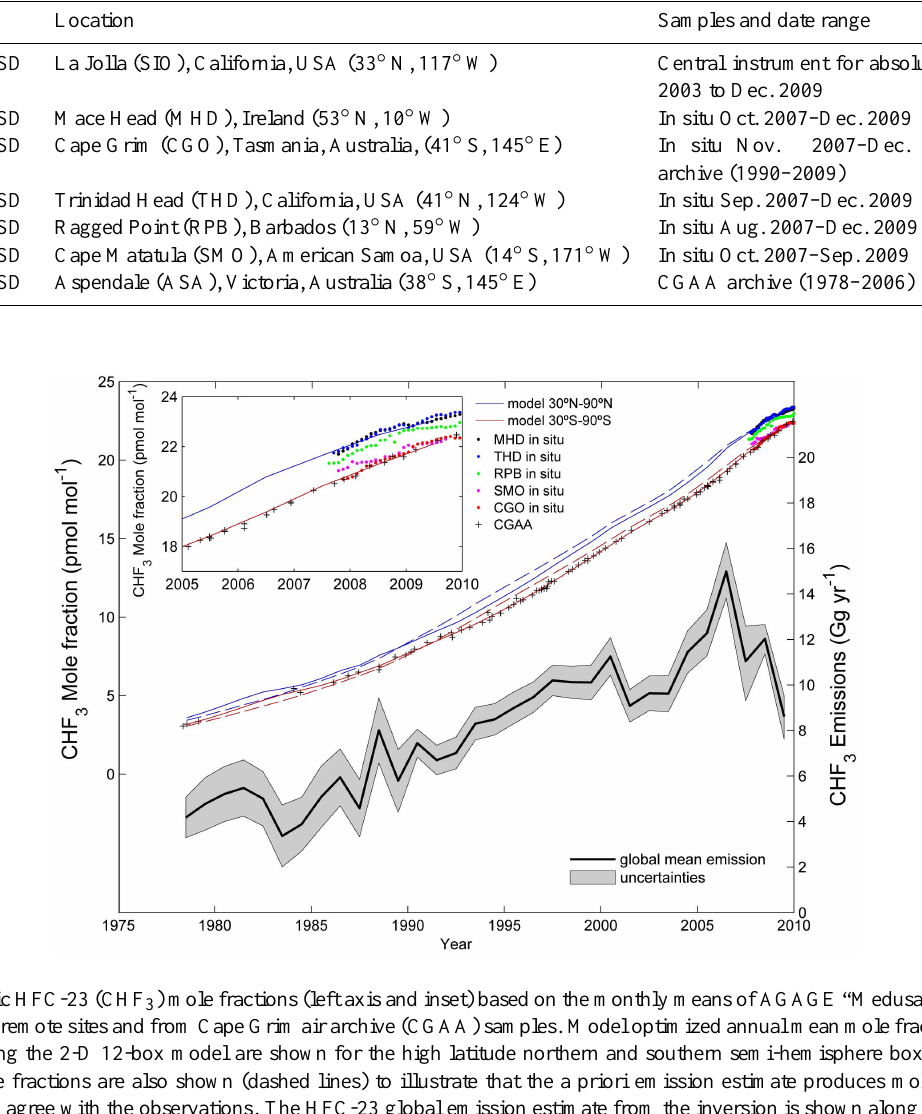
Table 1. Analytical instruments, locations and samples used in this study.